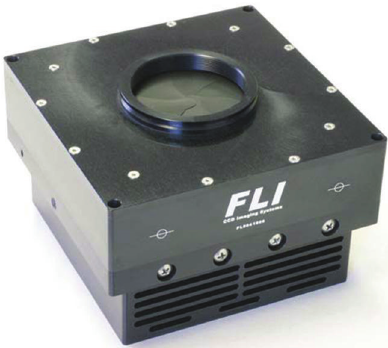
Figure 8: CCD Finger Lakes camera installed on the